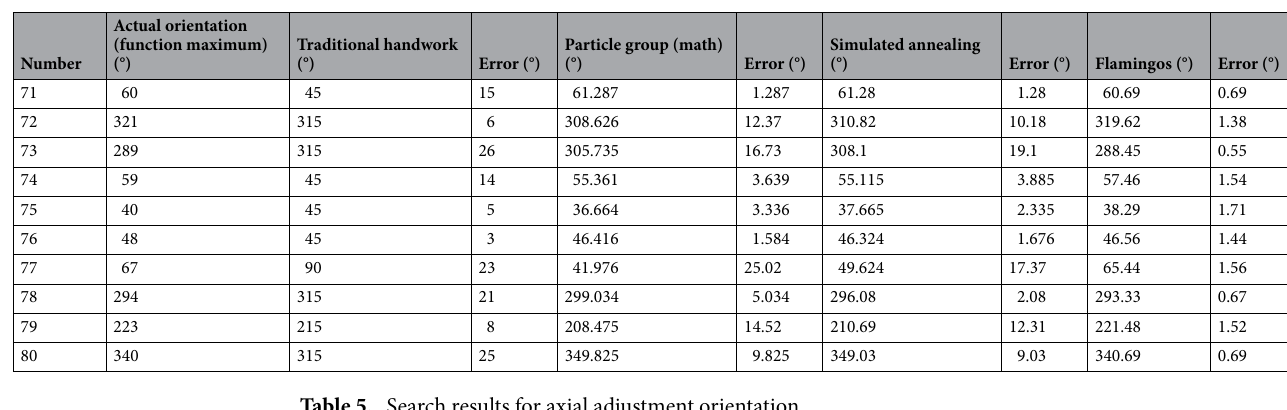
Table 5. Search results for axial adjustment orientation.